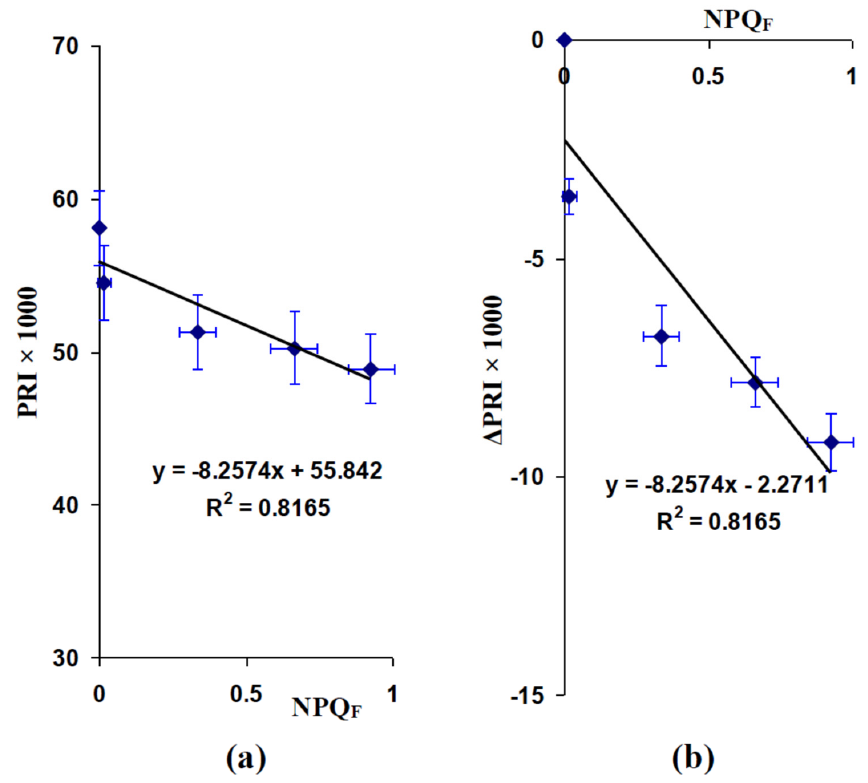
Figure 5. Scatter plots and linear regression trends between NPQ F and PRI ( a ) and between NPQ F and Δ PRI ( b ) in experiments with actions of ALs with different intensities. K I = − 8.2574 and K Δ I = − 8.2574 are linear regression coefficients in the plots ( a ) and ( b ), respectively. Average values of parameters and standard errors from Figure 3 were used. R 2 is the determination coefficient. Bars show standard errors.